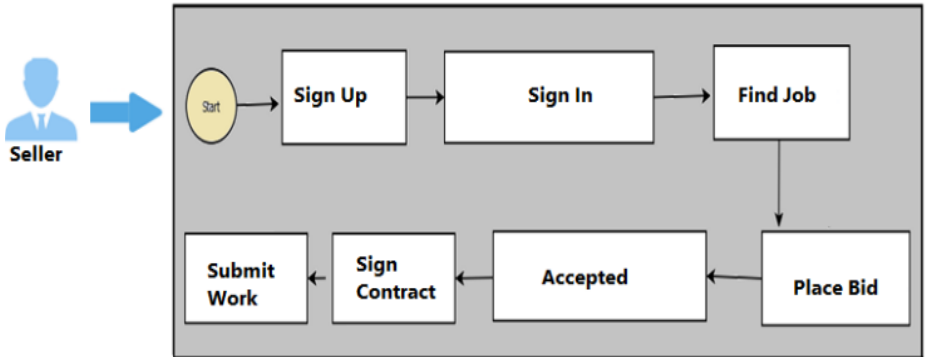
Figure 4. Seller work process in system.